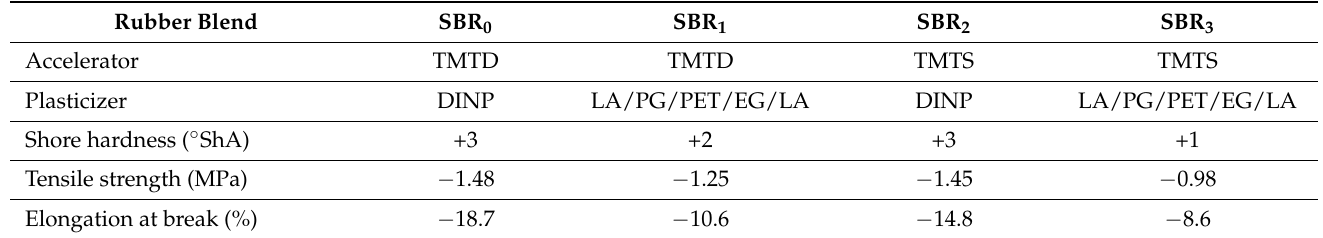
Table 13. The change of vulcanizate properties after aging at 100 ◦ C for 24